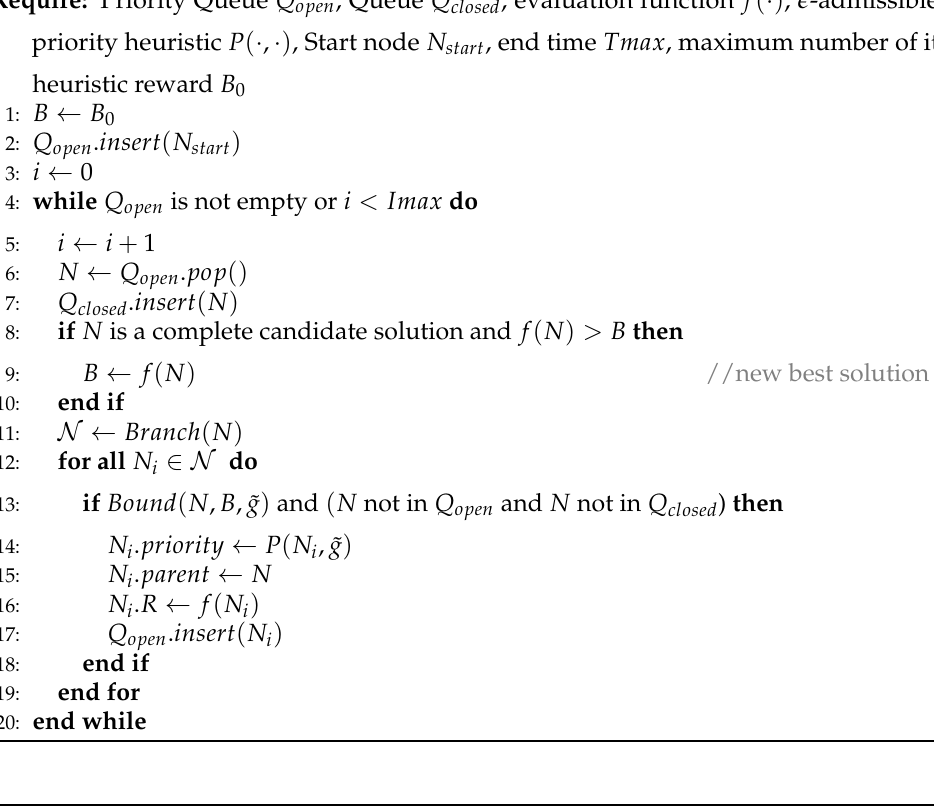
Algorithm 2 Branch ( N )